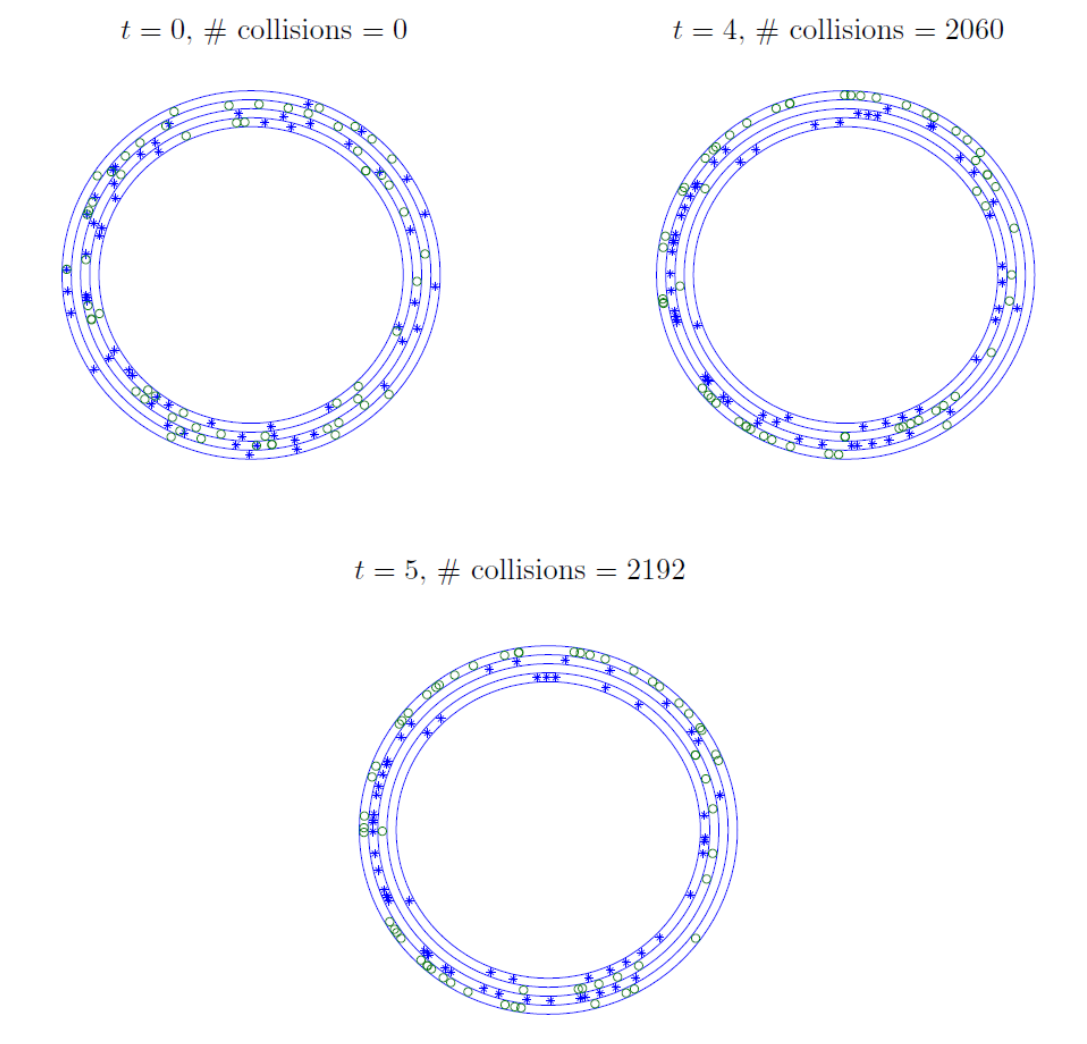
Figure 1. Positions of the pedestrians at different times. The circles are the pedestrians moving clockwise. The exes are the pedestrians moving